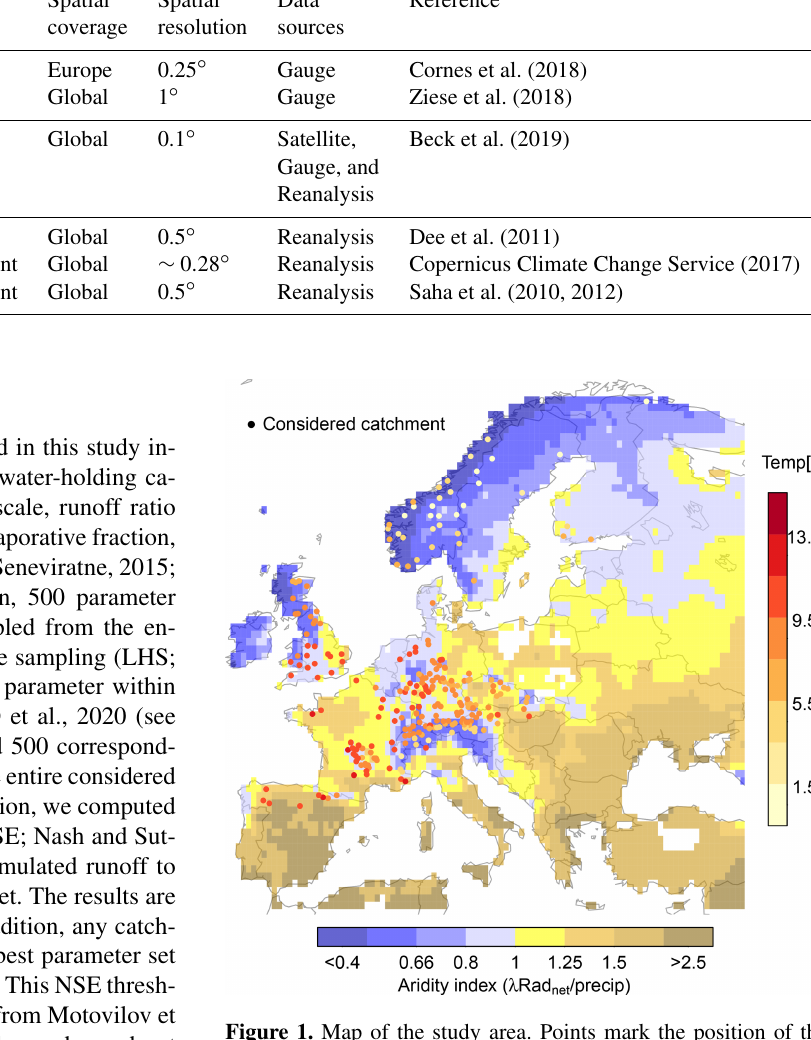
Table 1. Summary of the precipitation data sets evaluated in this study. Group